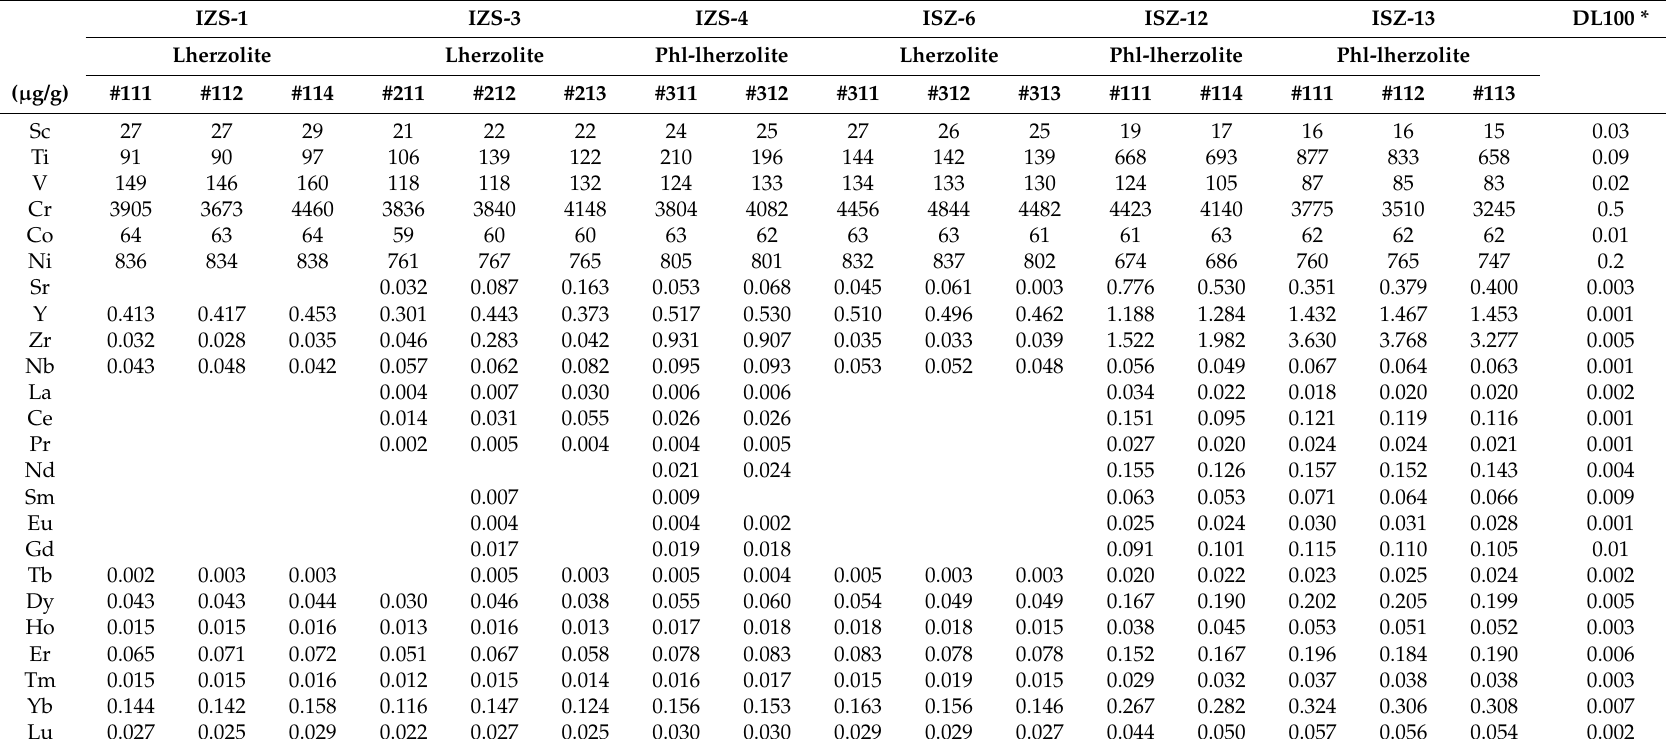
Table 4. Trace-element compositions of orthopyroxene in peridotite xenoliths from Bankawa, the SW Japan